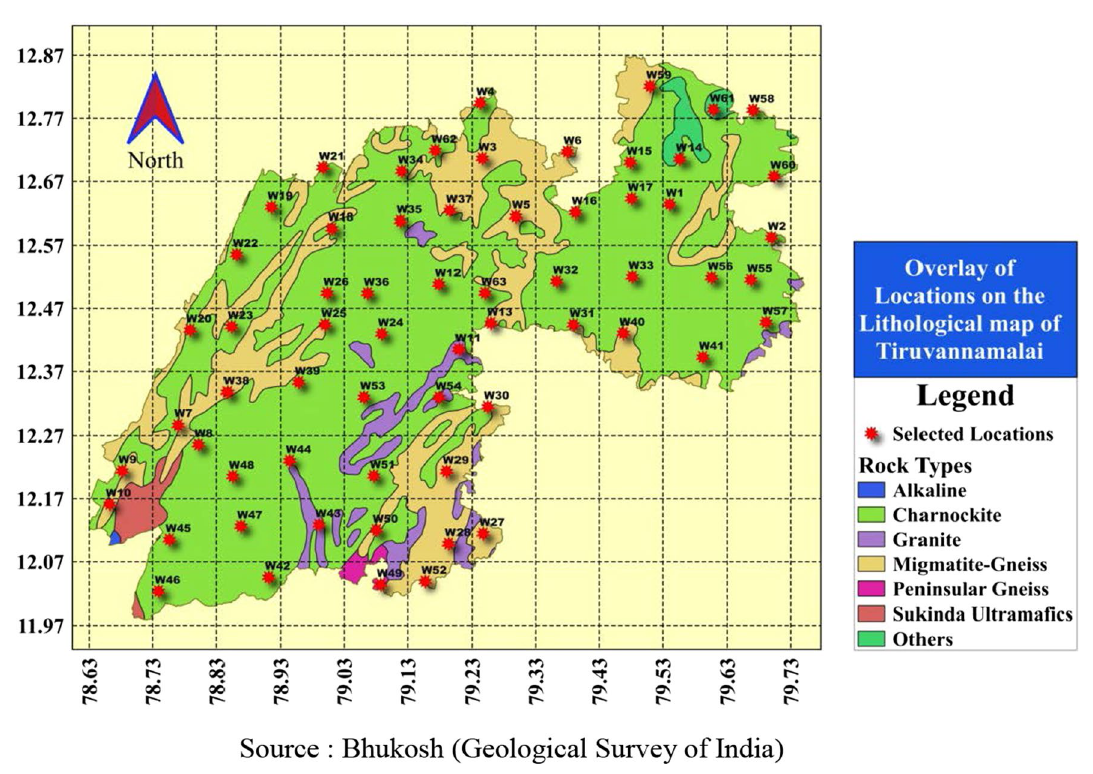
Fig. 3 Overlay of sampling locations on the lithology of the study area